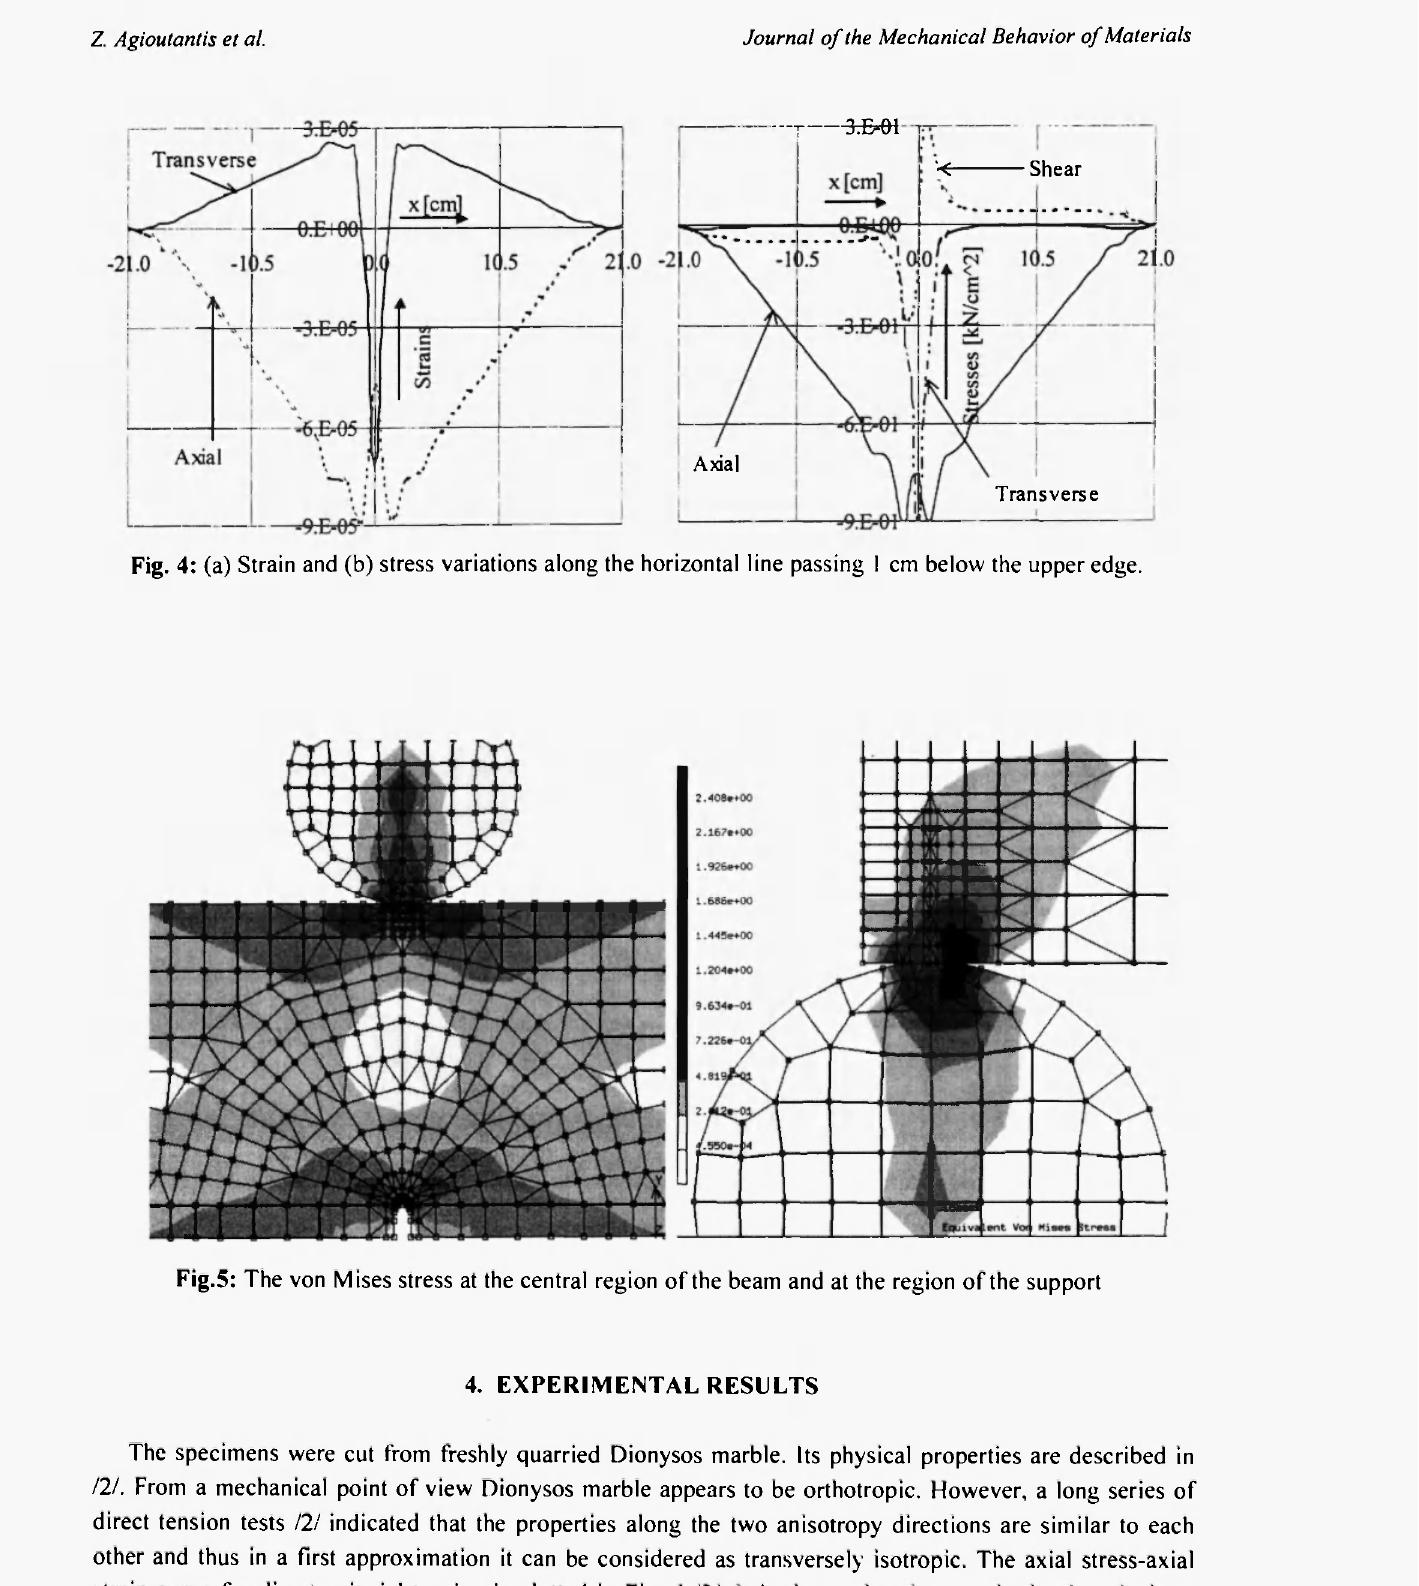
Fig.5: The von Mises stress at the central region of the beam and at the region of the